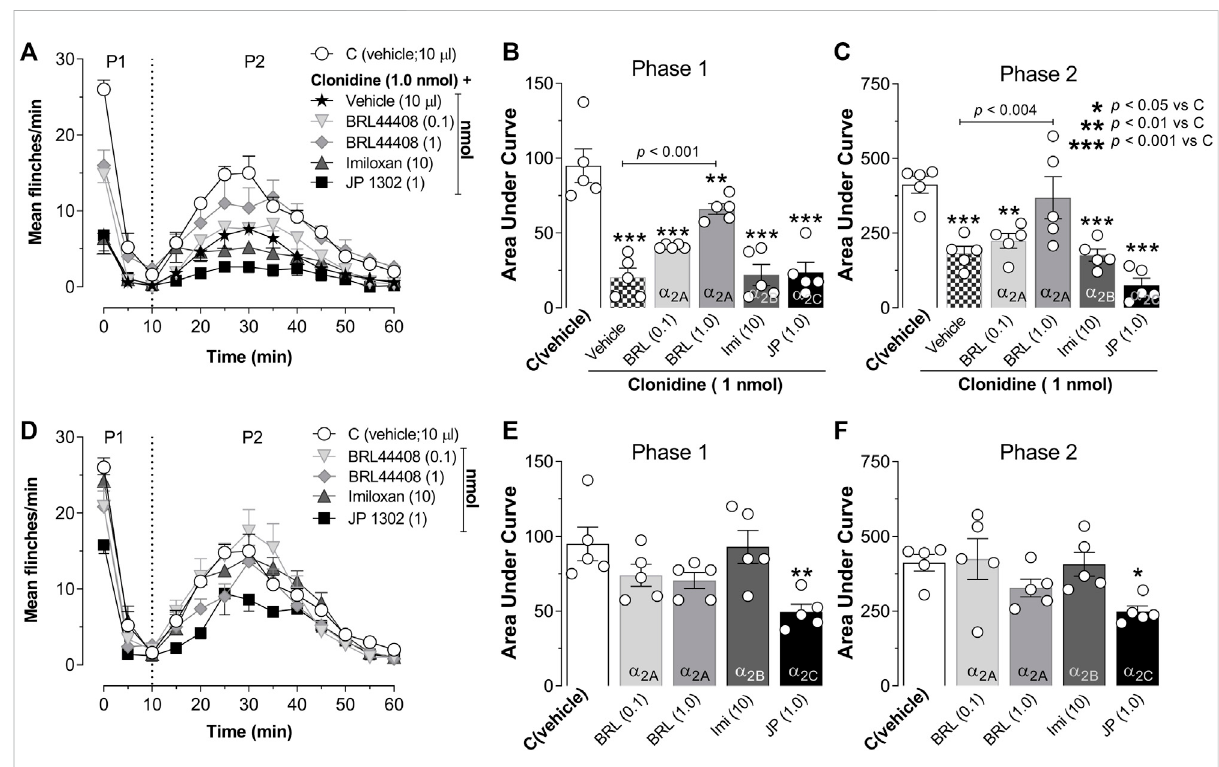
FIGURE 3 Role of spinal α 2A -adrenoceptors in the clonidine-induced behavioral antinociception and the antinociceptive effect of JP 1302 ( α 2C - adrenoceptor antagonist). (A) shows the effect of intrathecal (i.t.) injection of vehicle (10 μ l; isotonic saline solution) or α 2A/2B/2C -adrenoceptor antagonists on the clonidine-induced inhibition of the fl inches induced by formalin (1%; 50 μ l, s.c.) during phase I (P1) and phase II (P2). Vehicle, BRL 44408(0.1or1 nmol;an α 2A -adrenoceptorantagonist; n =5eachdose),imiloxan (10 nmol;an α 2B -adrenoceptorantagonist; n =5),orJP1302 (1 nmol;an α 2C -adrenoceptorantagonist; n =5)weregiveni.t.10 minpriorclonidine. (B,C) representthedataastheareaunderthemeannumberof fl inches against the curve (AUC) and show that BRL 44408 (1 nmol) inhibited the clonidine-induced antinociception in both phases (P1, P2). During P2, JP 1302 seems to enhance (statistically non-signi fi cant, p > 0.05) the antinociception induced by clonidine. (D) shows the per se effect of BRL 44408 (n = 5 each dose), imiloxan ( n = 5), or JP 1302 ( n = 5 each dose) in rats submitted to the 1% formalin test. The AUC in (E,F) suggest that BRL 44408 and imiloxan do not affect formalin-induced nociception. In contrast, JP 1302 diminishes the AUC values during both phases (P1, P2), suggesting an antinociceptive